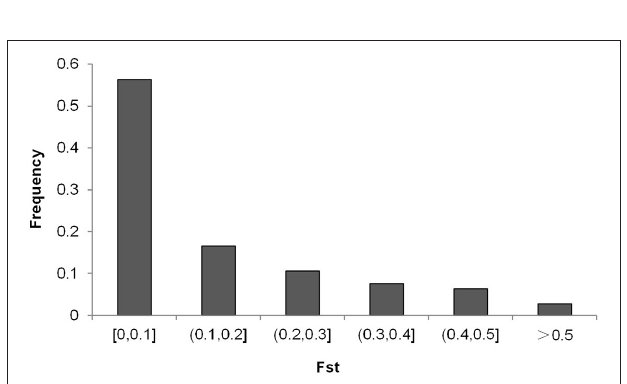
FIGURE 6 | Distribution of pairwise F ST -values among the two soybean subpopulations.